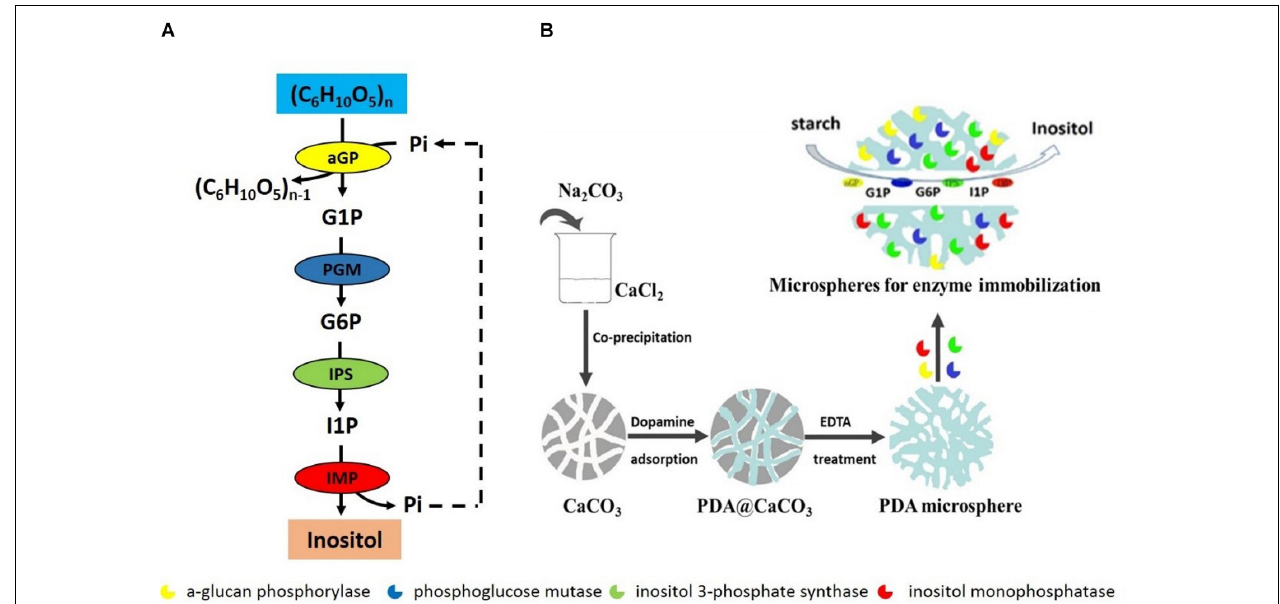
FIGURE 1 | (A) Scheme of in vitro synthetic enzymatic pathway for inositol synthesis from starch. (B) The scheme preparation process of immobilized enzymes on porous microspheres.